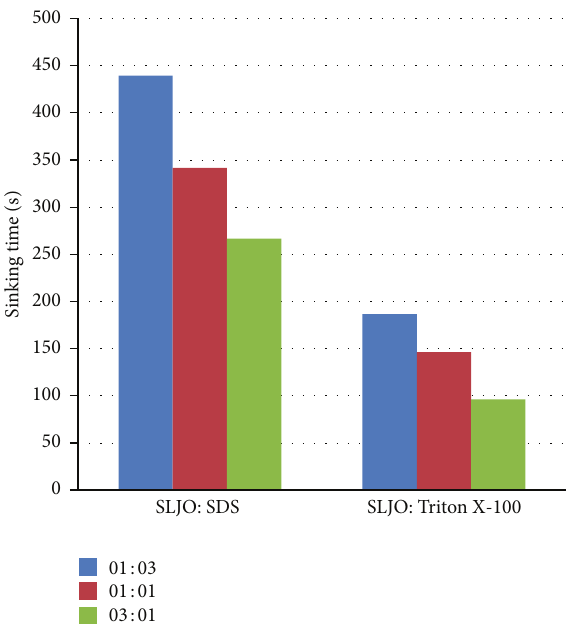
Figure 4: Effect of SLJO addition to improve wetting property of synthetic surfactants. Wetting improved with increasing proportion of SLJO.